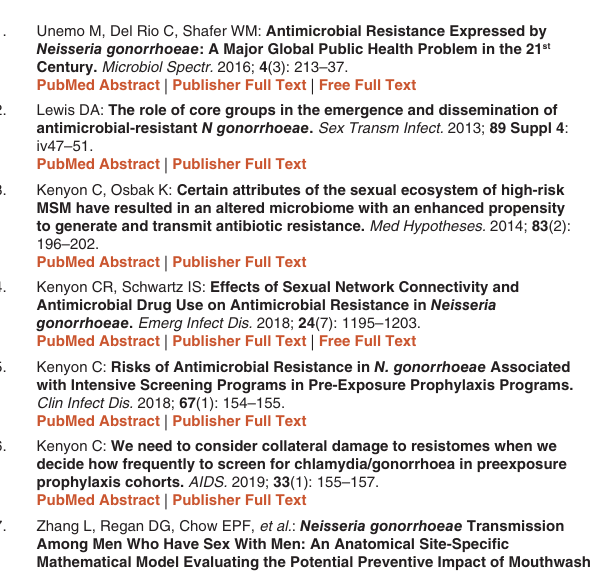
Figshare: In vitro gonococcal growth after exposure to mouth- washes. https://doi.org/10.6084/m9.figshare.9757859 11 . This project contains the following underlying data: - Data.xlsx (spreadsheet containing raw growth scores of the individual isolates after exposure to the experimental substances) Data are available under the terms of the Creative Commons Zero “No rights reserved” data waiver (CC0 1.0 Public domain